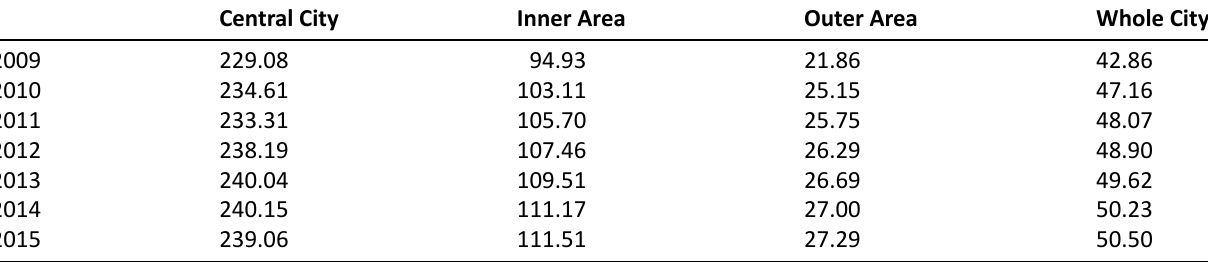
Table 2. Urban density (persons/ha) by different districts in Beijing from 1980 to 2013. Source: Compiled based on data provided by the Beijing Municipal Bureau of Statistics (BJMBS, 1982–2015, 2016).